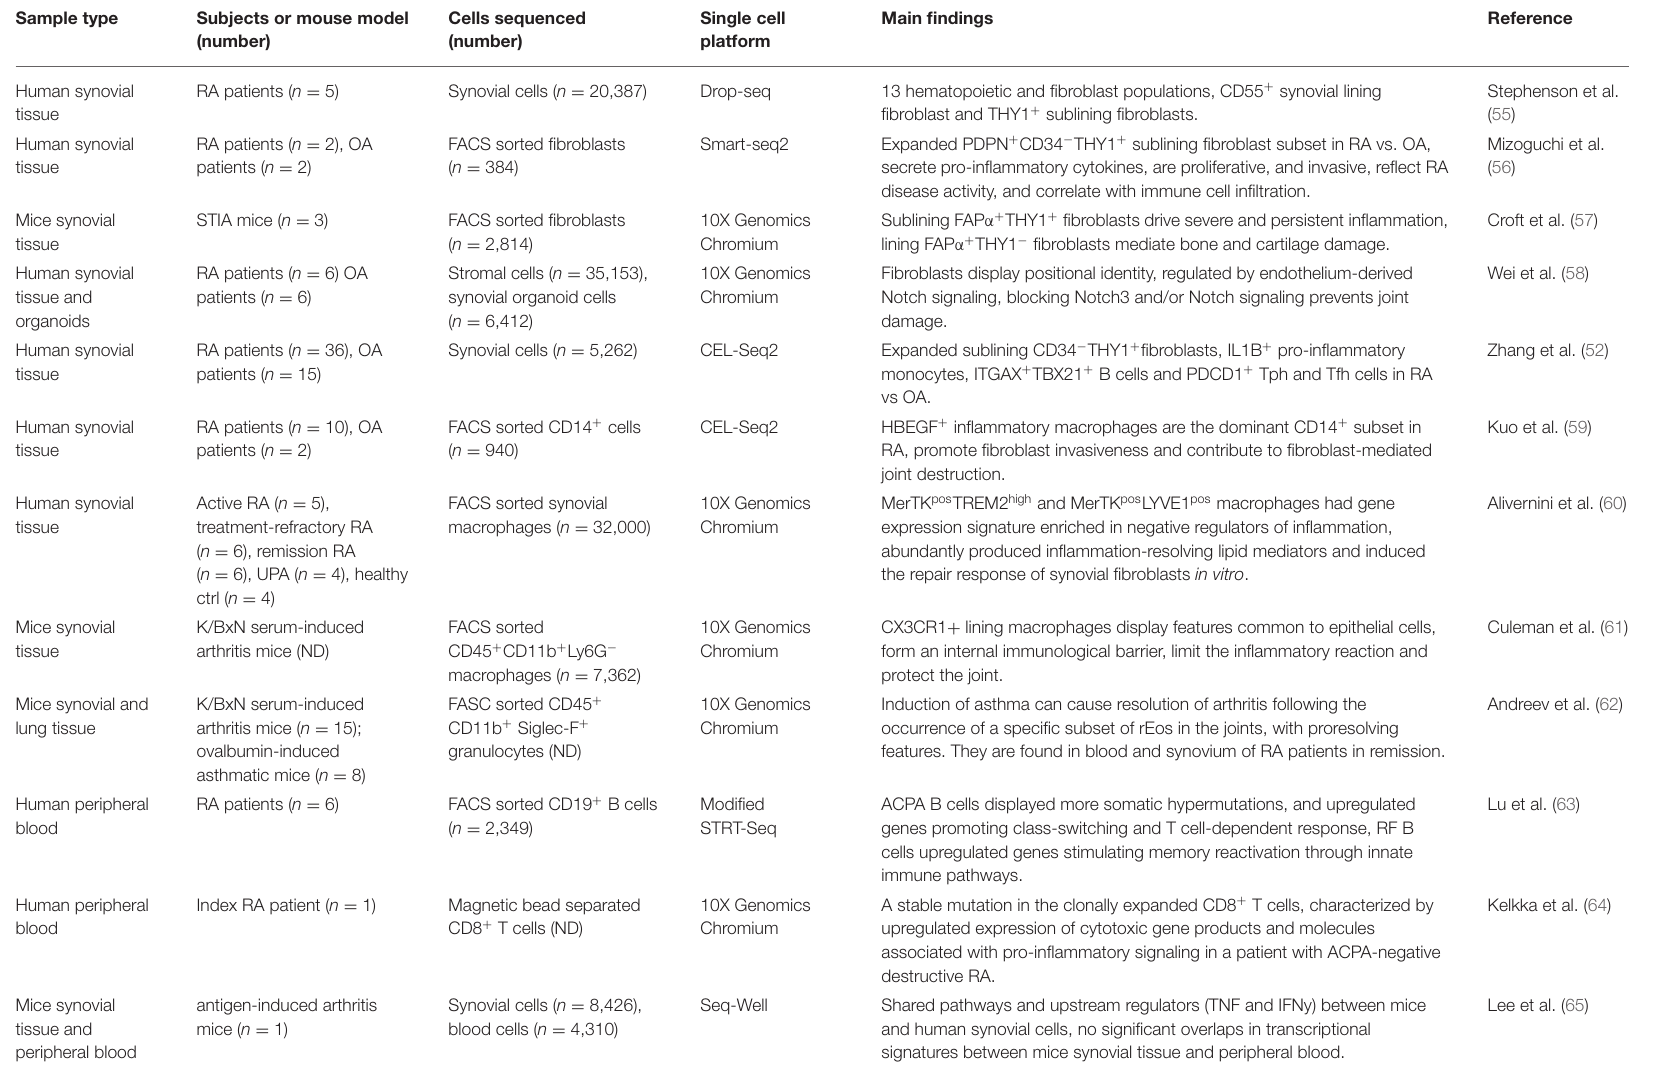
TABLE 1 | Application of scRNA-seq technology in rheumatoid